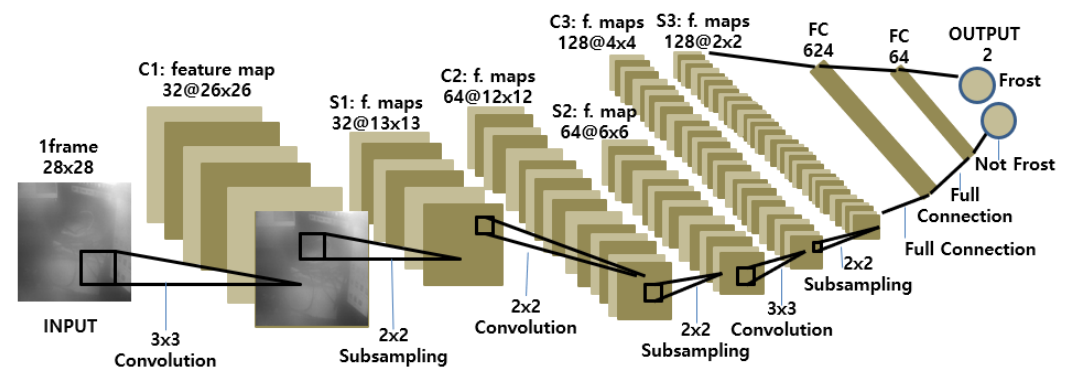
Figure 4. Structure of the convolutional neural network (CNN) used for frost